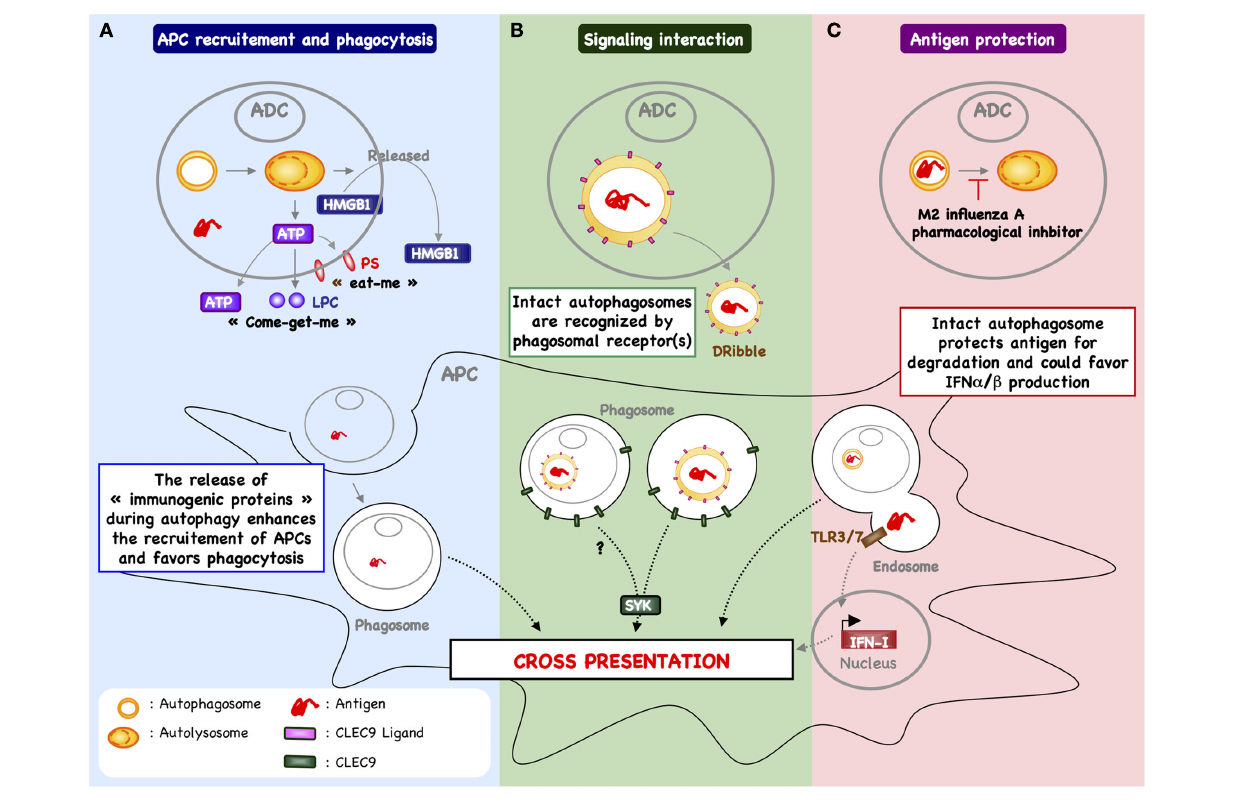
antigen – passively released following cell death or actively secreted – may be recognized directly by APC, inducing a signal transduction pathway that leads to increased cross-presentation. One example includes DRibbles-derived antigen cross-priming that is partially dependent of CLEC9A (Li et al., 2011).These data suggest that autophagosome express the ligand of CLEC9A, which is recognized by APC to enhance cross-priming. (C) Blocking autophagic flux in antigen donor cells – using pharmacological inhibitor or during influenza A infection – favors antigen cross-priming (Uhl et al., 2009). In this context, it is possible that inhibition of lysosomal fusion serves to protect epitope within the autophagosome of dying cells and facilitates delivery of intact or partially processed antigen to APC. In addition, the capture of intact autophagosome could enhance cytokine production (e.g., type I interferon) and cDC